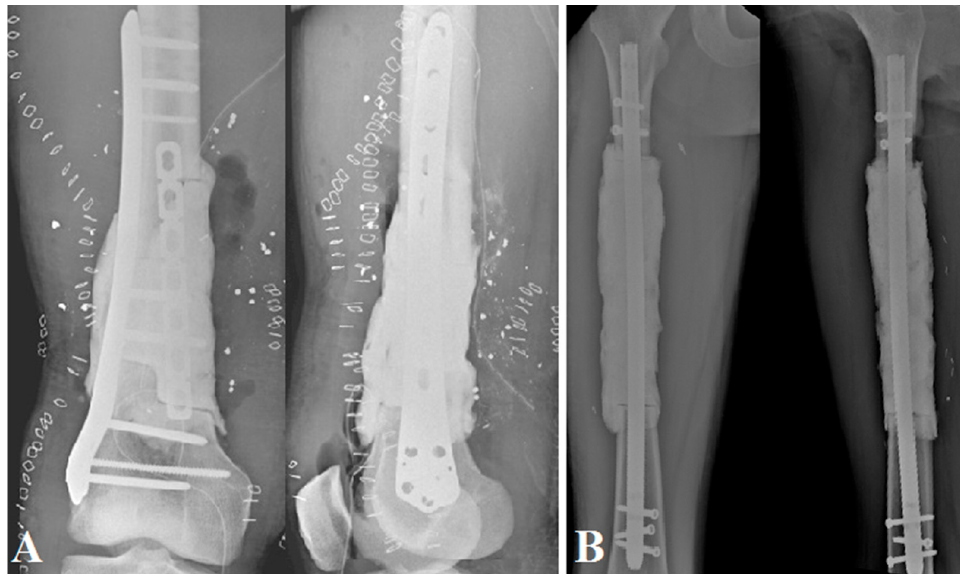
Figure 1. Postoperative X-ray AP and lateral view of the spacers: ( A ) a plate-enhanced spacer on a bone defect with step-cut in setting a septic ballistic trauma of the right distal femur (patient No. 4); ( B ) an intramedullary nail-enhanced spacer on a bone defect after an Ewing sarcoma resection.